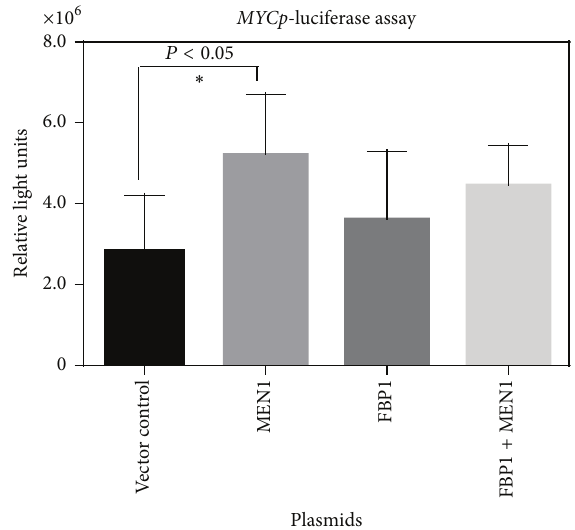
Figure 3: Menin induces MYC promoter. MYC p-luciferase assay of HEK293 cells transfected with a MYC p-luciferase construct and the indicated plasmids. The data are the average of the luciferase activity from 6 independent transfections after normalization for total protein concentration. ∗ Representative of 𝑃 < 0.05 . Error bars represent ±